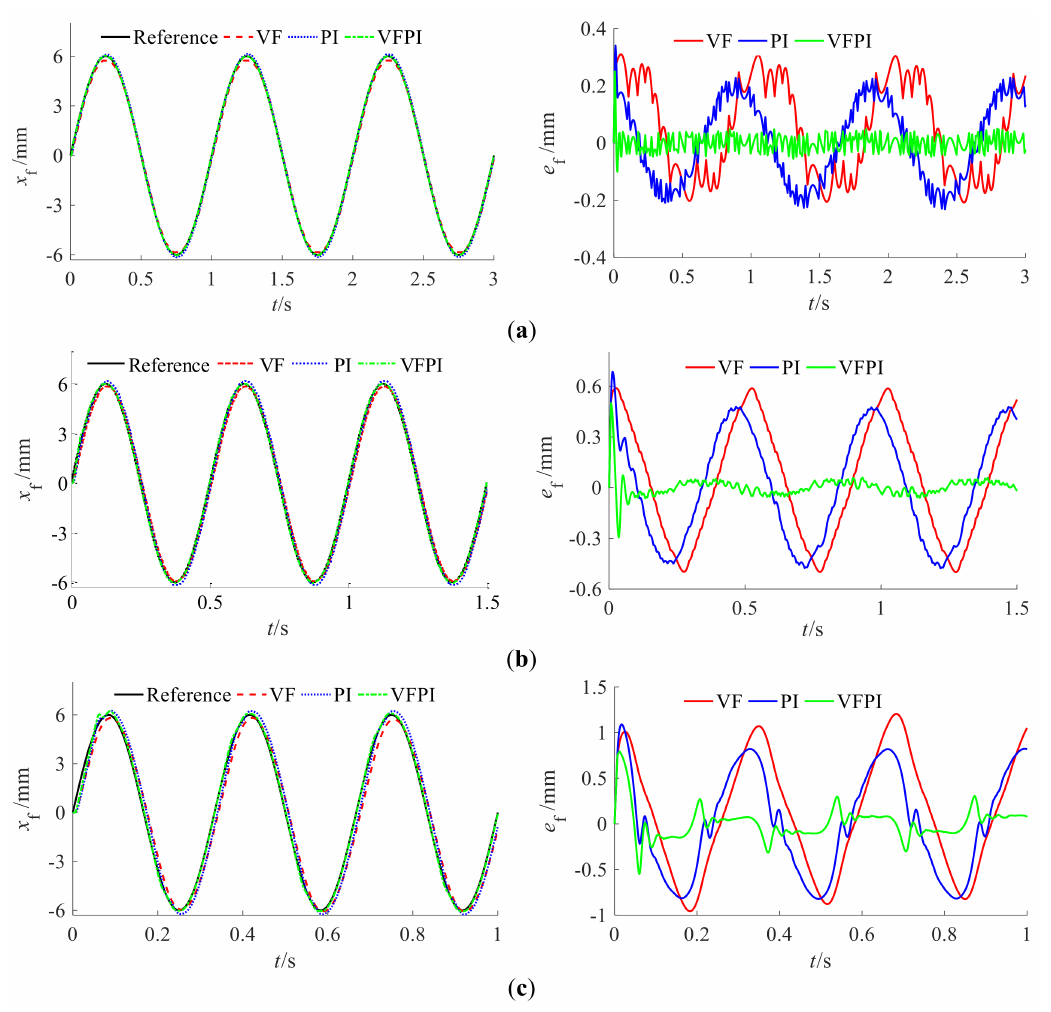
Figure 11. Comparison between the tracking performances while tracking the sinusoidal trajectory with different frequencies (amplitude is 6 mm): ( a ) 1 Hz; ( b ) 2 Hz; ( c ) 3